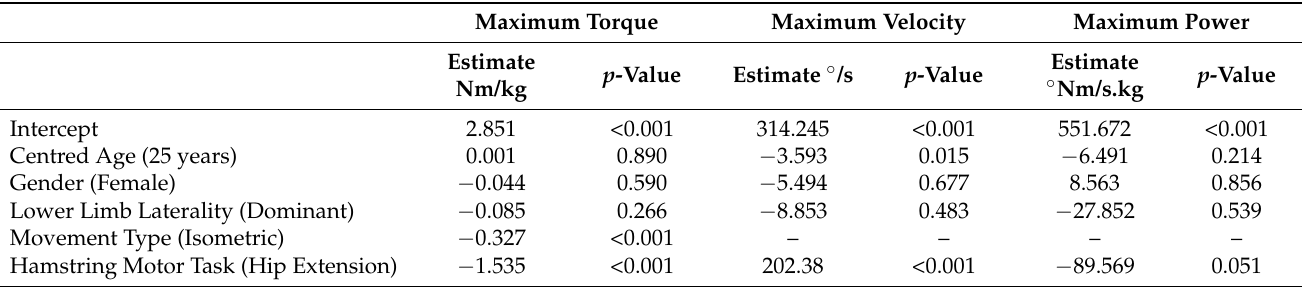
Table 3 is the result of a multiple linear regression analysis of all data collected for this paper. Three dependent variables are displayed column wise, whereas the independent variables are shown line wise: gender, age, lateral dominancy, type of motor task and inclusion of agonist muscles in the movement. Table 3. Multivariate regression analysis of torque, velocity, and power. Maximum